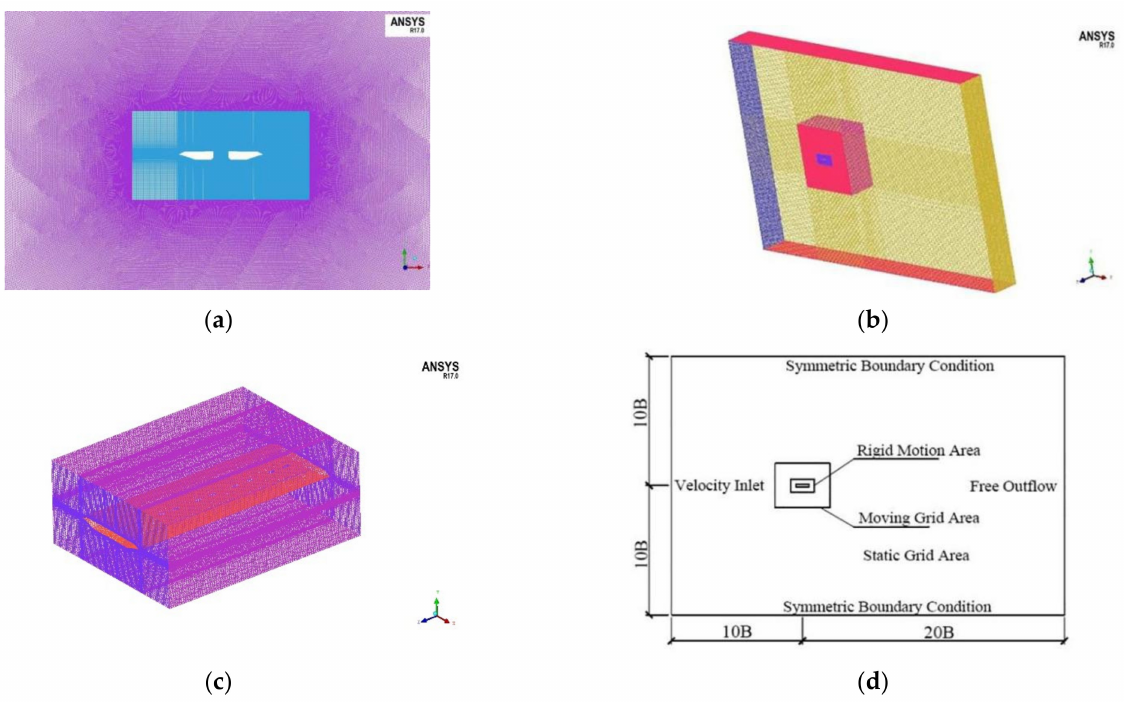
Figure 5. Boundary conditions and demarcation of grids. ( a ) Grid demarcation of 2D model of a bridge section; ( b ) Grid demarcation of 3D model of a bridge section; ( c ) Details of grid demarcation of a rigid area; ( d ) Boundary